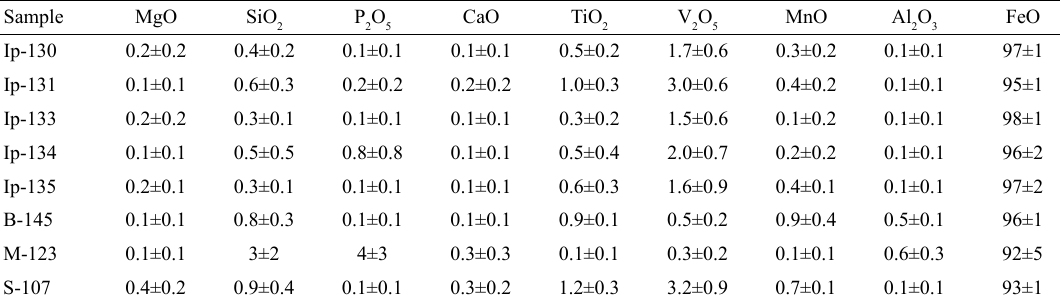
Table 4: Average EDX microanalysis results of the wüstite phase of the slag inclusions